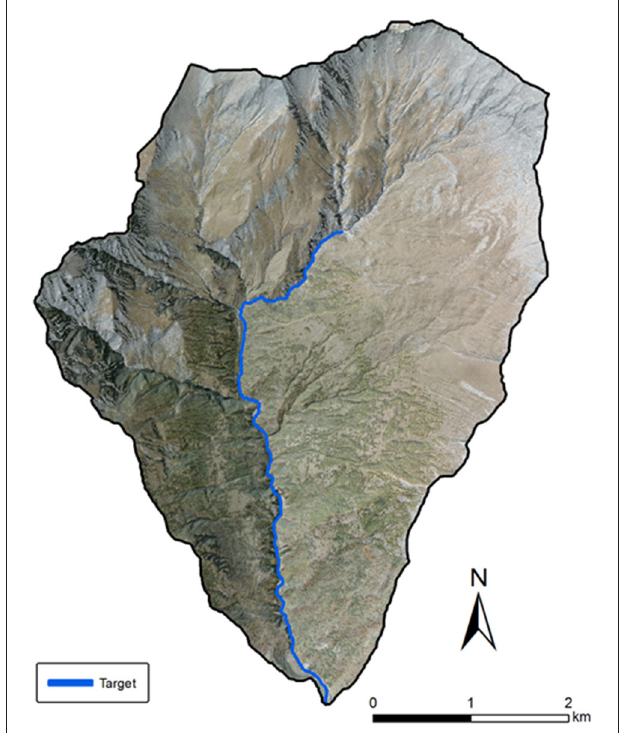
FIGURE 3 | Frejus catchment study area, shaded relief map in transparency with aerial view of the study area. The main permanent drainage network is highlighted and has been selected as target for IC